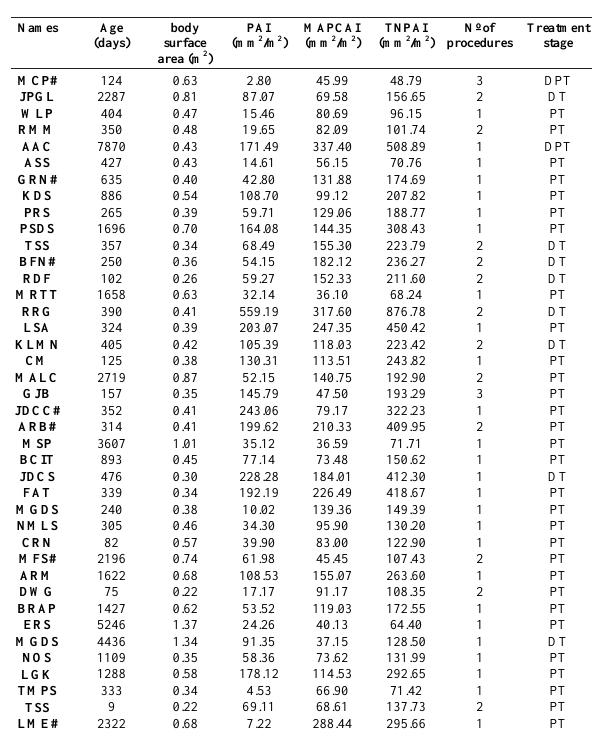
Table 2. Morphometric characteristics of the pulmonary arteries and major aortopulmonary collateral arteries surgical procedures and treatment stages in relation to the age and the body surface area in Group